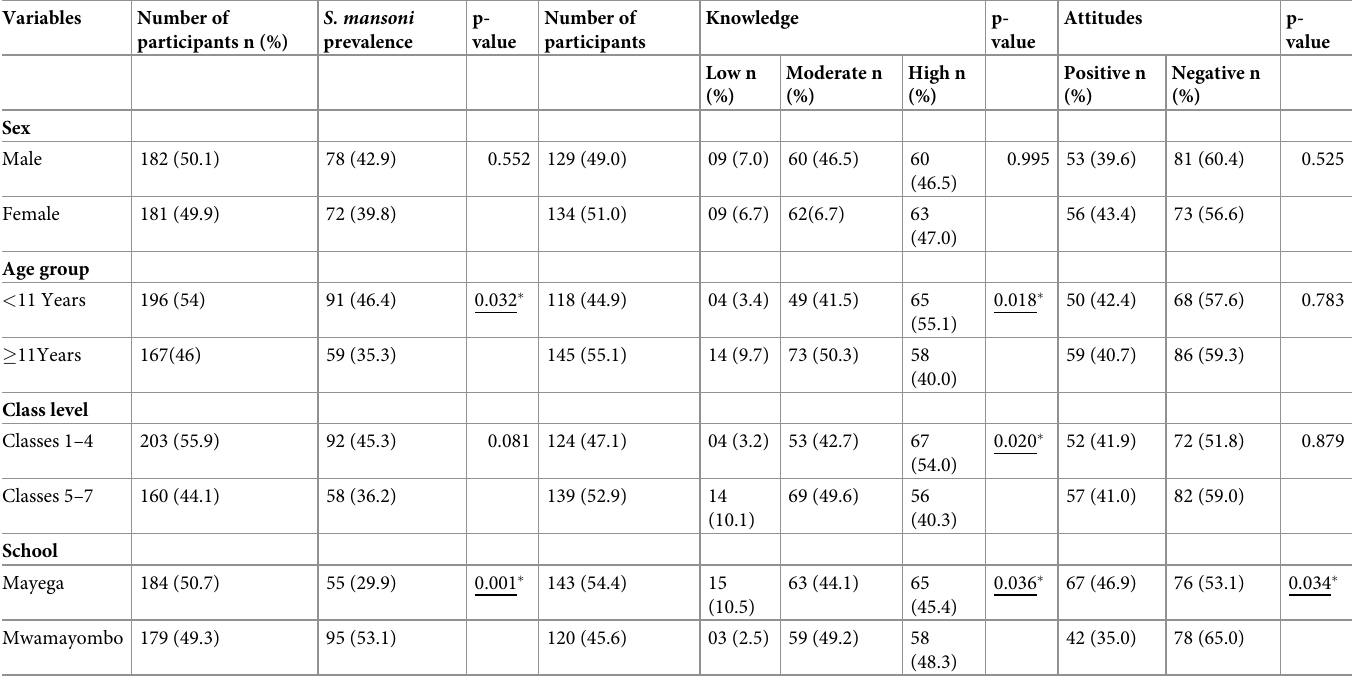
Table 1. Socio-demographic factors, the prevalence of S . mansoni infection, levels of knowledge, and attitudes among the participants.